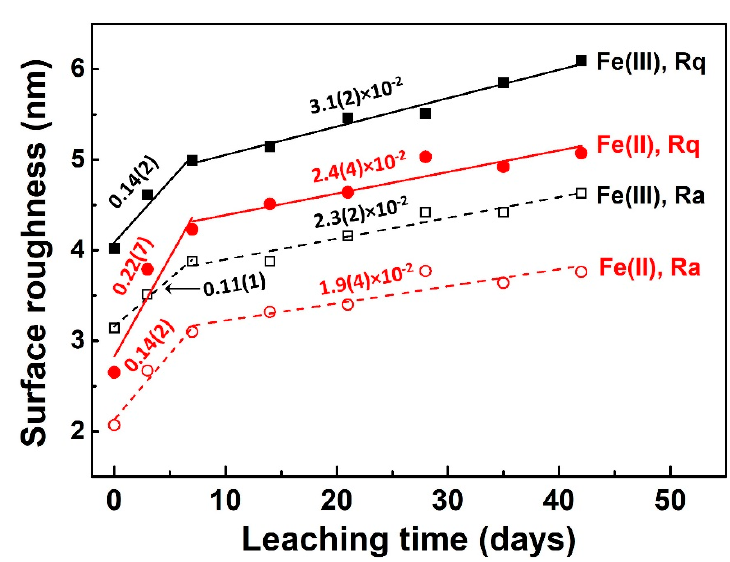
Figure 7. The surface roughness, Rq and Ra, of the boxed areas for the chalcopyrite (112) surfaces leached at pH 1 and in the presence of ferric and ferrous. Slopes correspond to rates (nm / day) of increase in AFM surface roughness, with errors from linear regression given in parentheses.